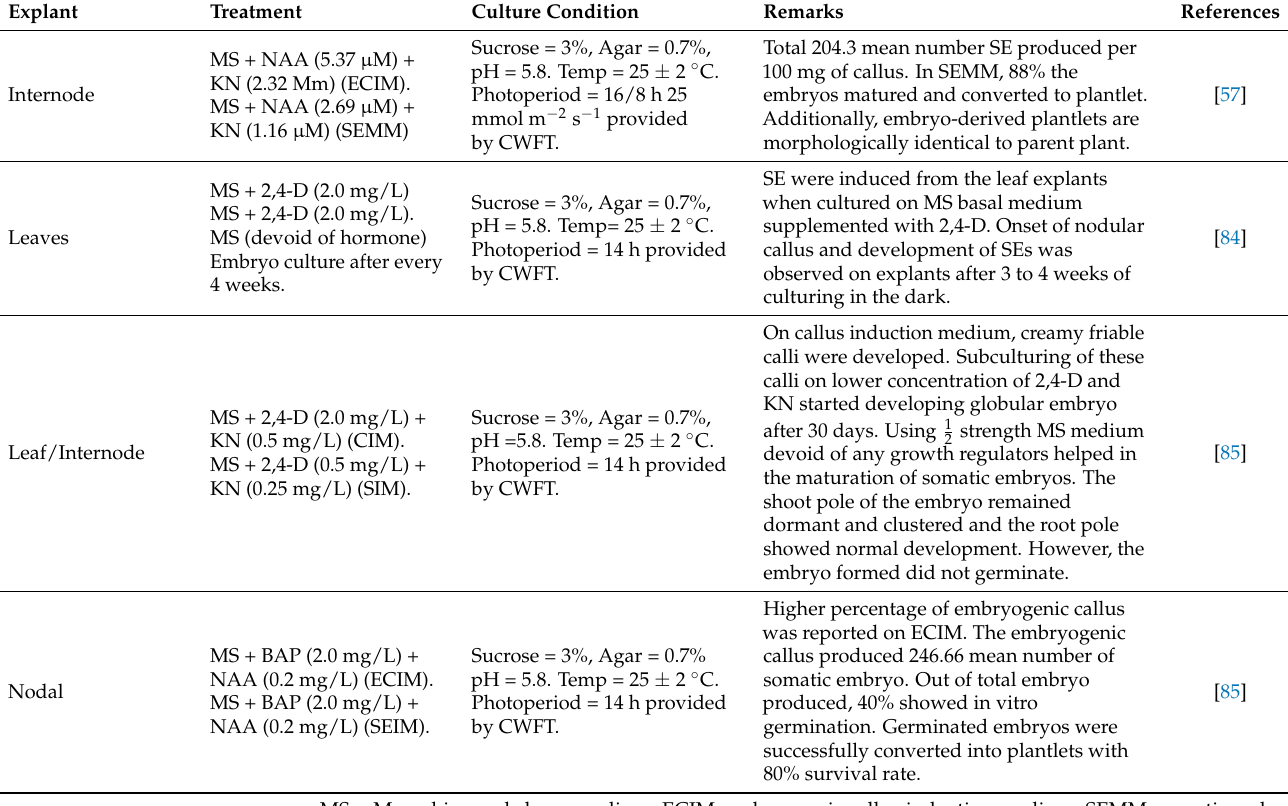
Table 5. Indirect organogenesis in C. asciatica